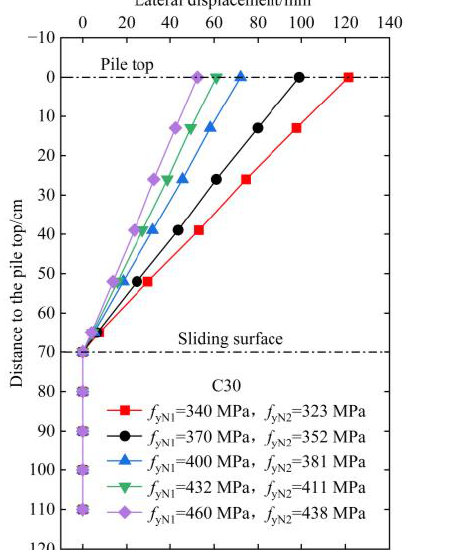
Figure 24. Variations of the pile displacement and bending moment with respect to concrete strength. ( a ) Pile displacement; ( b ) pile bending moment.